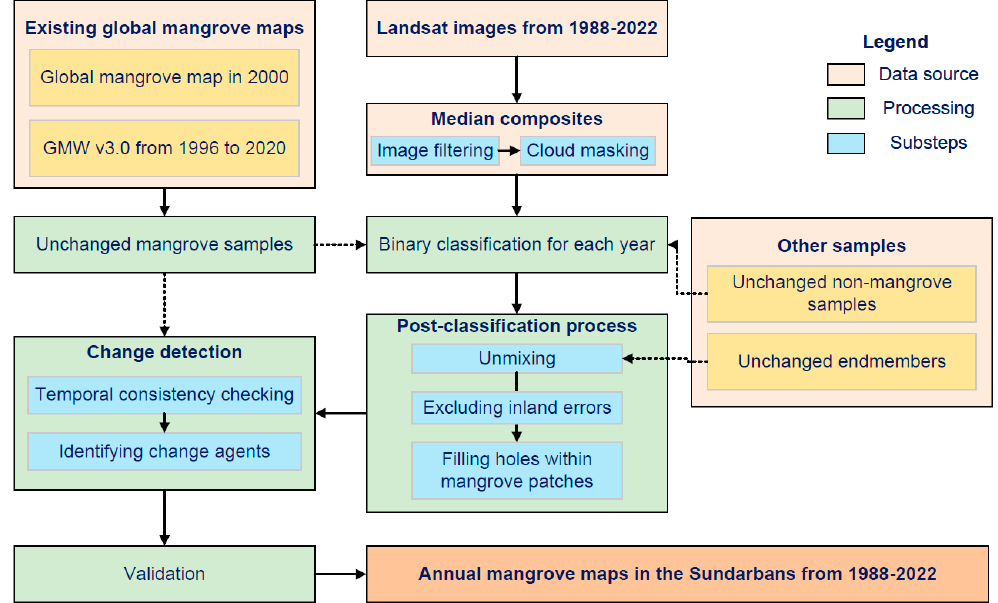
Figure 3. Methodological workflow for the detection of mangrove changes.